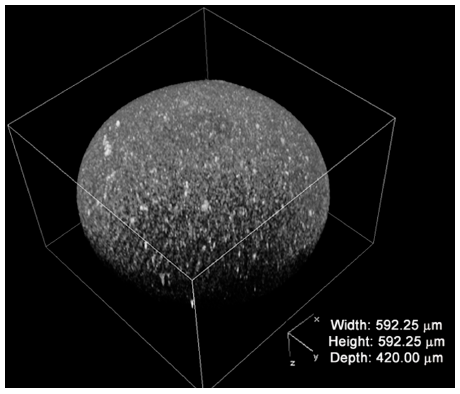
Figure 2. Fibroin coating reconstruction by confocal microscopy of fibroin-coated alginate microcarriers (FAMs).